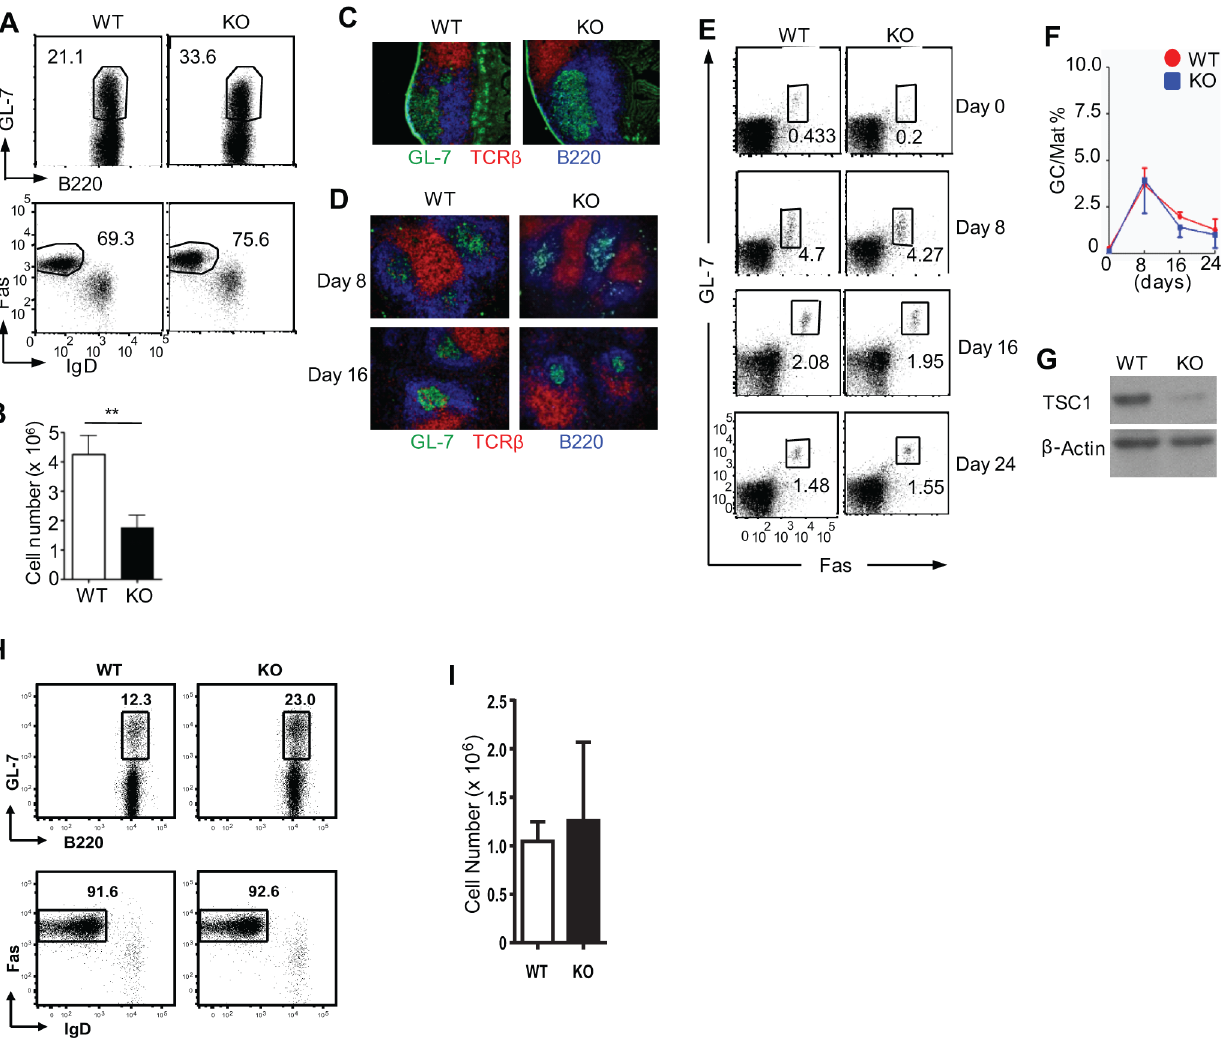
Fig 5. TSC1 in B cells is not required for germinal center formation. (A-C) Assessment of PP GC in WT and TSC1KO mice. (A) GL-7 and Fas staining in live-gated CD93 - B220 + compartment from WT and TSC1KO PPs. (B) Total cell number in PP (n = 7). (C) Architecture of PPs revealed by immunofluorescent microscopy. Frozen thin sections of PPs were probed with B220-AF350 (blue), TCR-PE (red), and GL-7-FITC (green) antibodies. FITC signal was amplified using anti-FITC-AF488 antibody. Images were acquired using a Zeiss Axiovert 200M confocal immunofluorescent microscope. (D-G) Assessment of GC formation in WT and TSC1KO spleens following immunization. Mice were i.p. injected with 20 μ g NP 11 -CGG precipitated in alum. Spleens were harvested at days 0, 8, 16, and 24 postimmunization. (D) Detection of GC in the spleen 8 days and 16 days after immunization by immunofluorescence. (E, F) GC B cell frequencies measured by flow cytometry. (E) Representative dot plot of GL-7 and Fas staining in live-gated CD93 - B220 high cells. (F) Percentage of GL- 7 + Fas + IgD - GC B cells within the CD93 - B220 high population (n = 6). (G) Detection of TSC1 protein in sorted CD93 - B220 high GL7 + Fas + GC B cells from WT and TSC1KO splenocytes 8 days after immunization by immunoblotting. (H, I) GC B cells in PP from WT and TSC1KO mice in C57/BL6-129 mixed background. (H) Representative dot plots. (I) GC B cell numbers (n = 4). Data were calculated from four (A-C), three (D-G), or two (H, I) independent experiments. ** p <